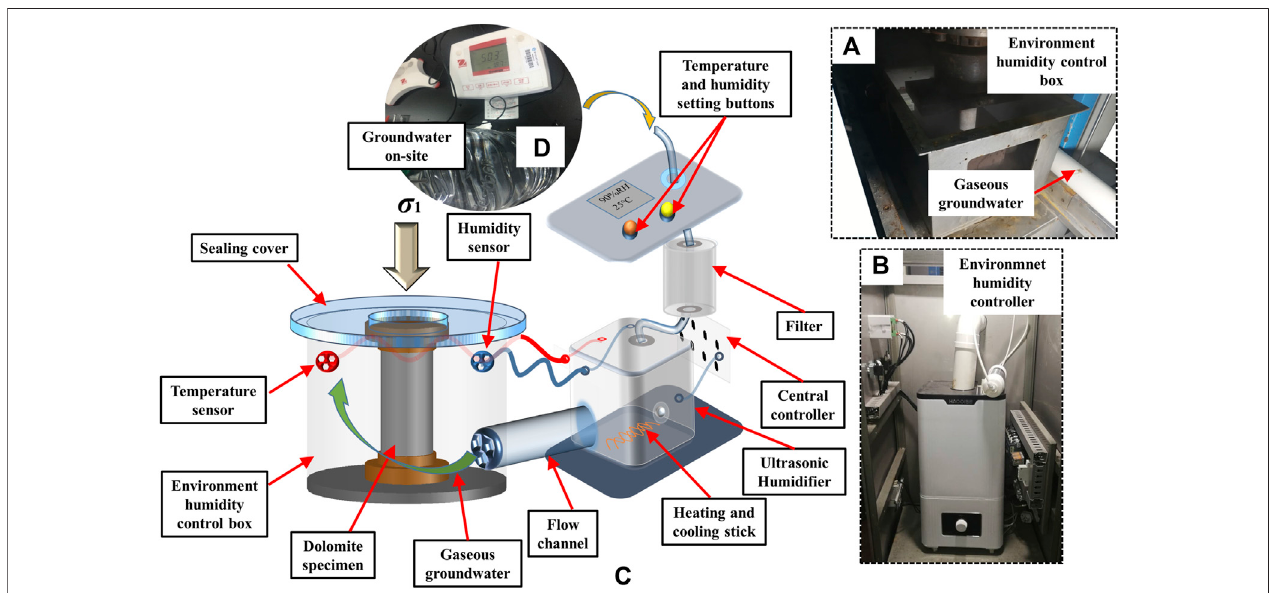
FIGURE 2 | Realisation of high-humidity environment: temperature and humidity environment control modeling device for rock mechanics experiments: (A) Environment humidity control box; (B) Environment humidity controller; (C) The diagram illustrating the operation of the device; (D) Groundwater taken on-site. (Chen et